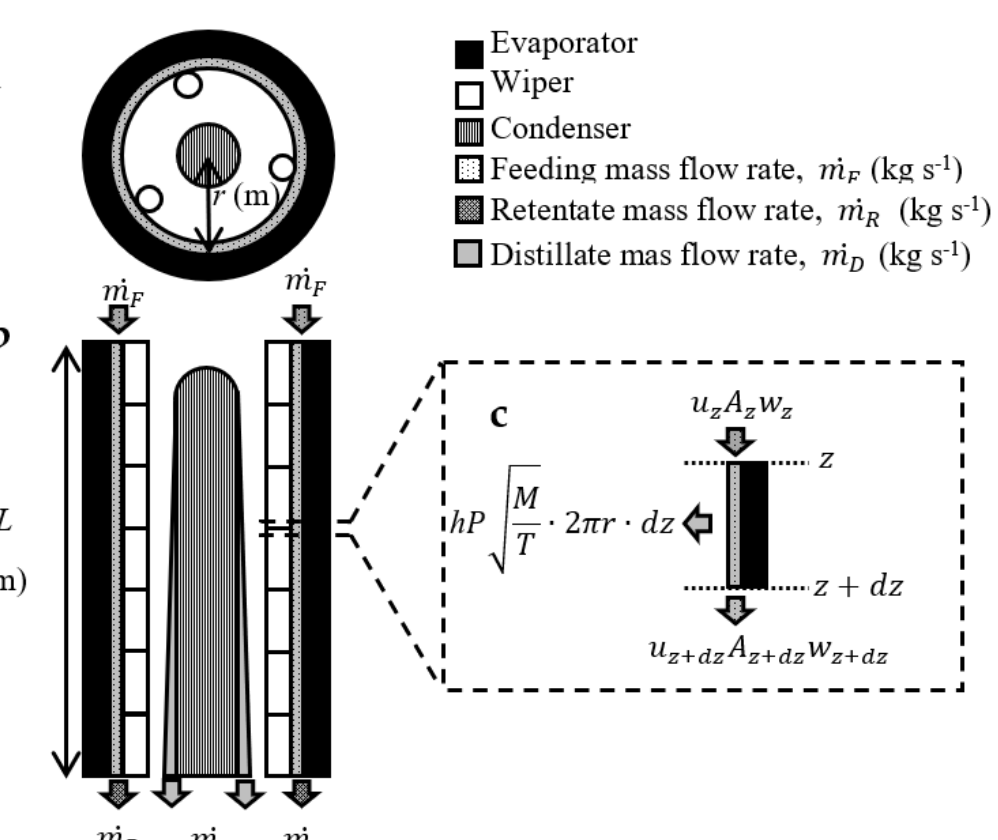
Figure 5. A simple drawing of evaporation chamber in ( a ) top view and ( b ) cross-sectional view to explain a mass flowing during the distillation. ( c ) Assumption of the proposed mathematical model in small boundary area at